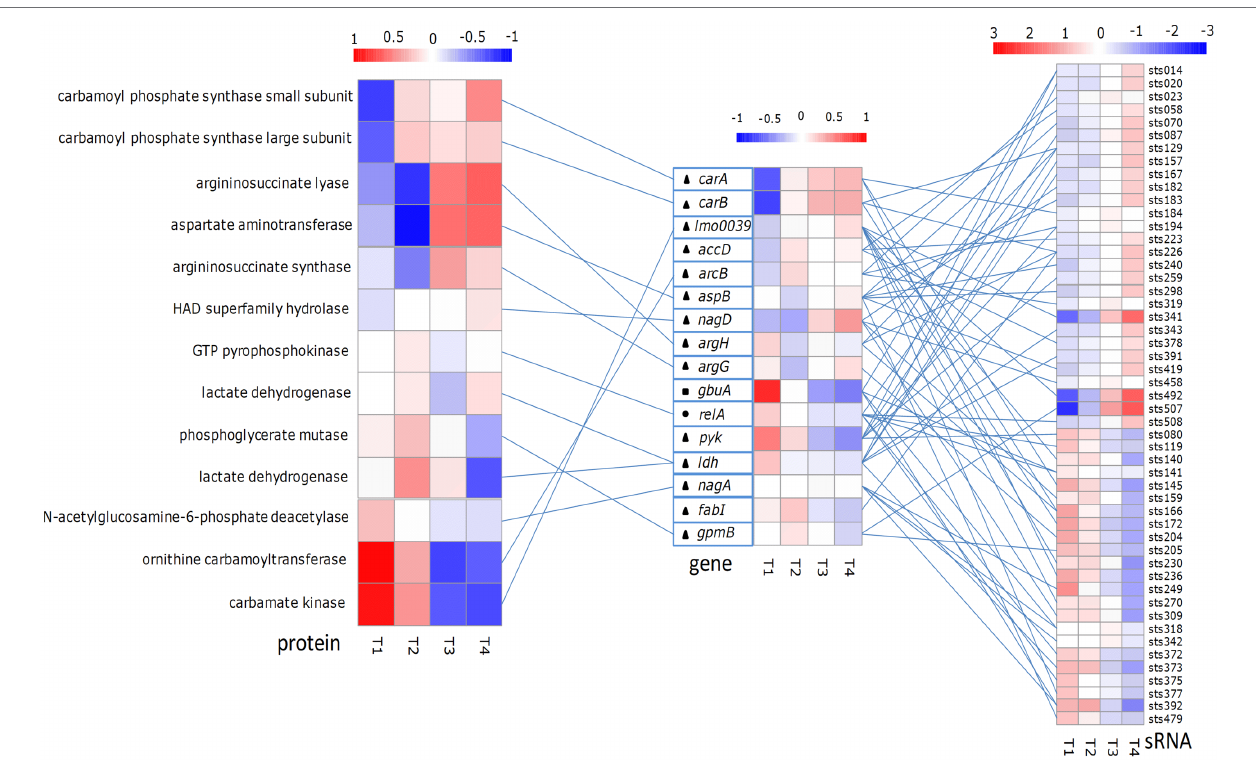
FIGURE 4 | Some Streptococcus thermophilus proteins associated with starvation stress-, acid stress- and osmotic stress-related sRNAs, and their target differential expression heat map. The left panel shows the protein expression heat map; the middle panel shows the sRNA-targeted gene expression heat map; and the right panel shows the sRNA expression heat map. The color associated with gene and protein expression ranges from low (blue) to high (red). Heat map on the left: each column represents a library listed below, and each row represents a protein. Middle heat map: each column represents the next library, and each row represents a gene. Right side panel: each column represents the library listed below, and each row represents one sRNA. T1, T2, T3 and T4 indicate the late-lag (early-exponential), mid-exponential, late-exponential, and stationary phases, respectively. Circles, squares and triangles indicate genes involved in starvation stress, osmotic stress and acid stress, respectively. The lines between protein, gene and sRNA show the expected